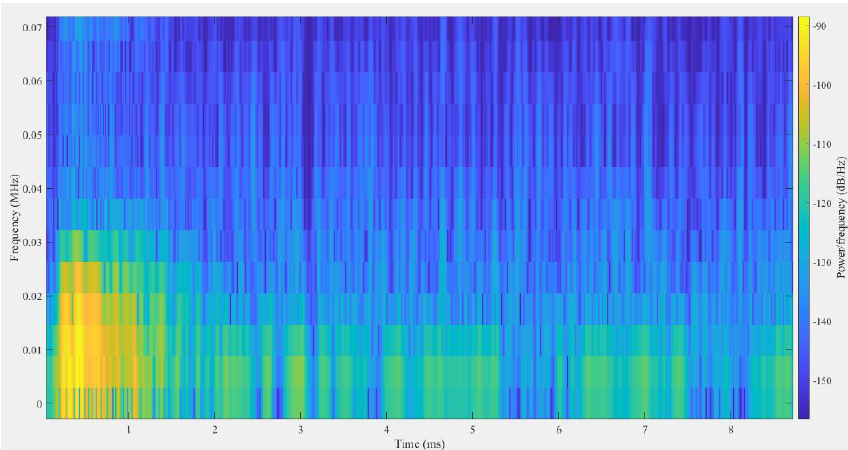
Figure 32. Time-frequency diagram of low frequency signal in S2 noise signal.